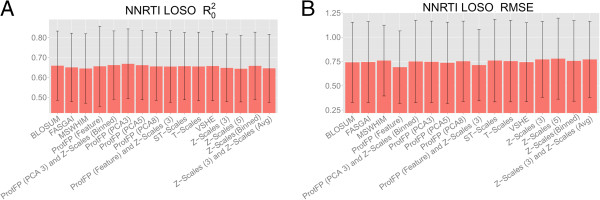
Mean performance of the benchmarked descriptor sets in the NNRTIs LOSO validation experiments. The mean is calculated over all 14 mutants and the error bar represents the standard deviation. Shown are the R02(A) and the RMSE (B). Note that error bars are large due to different performance between models trained on different mutants, not between repeats of the individual models. Extrapolation takes place on the target side as the test set contains unseen targets. The differences between individual descriptor sets are still small but the spread of the standard deviation increases. Again for individual receptors larger performance differences occur (see main text and Additional file
1: Figure S10 for details). In this part of the study ProtFP (Feature) shows very good performance, which indicates that a simplified representation on the protein side is favorable for this data set.